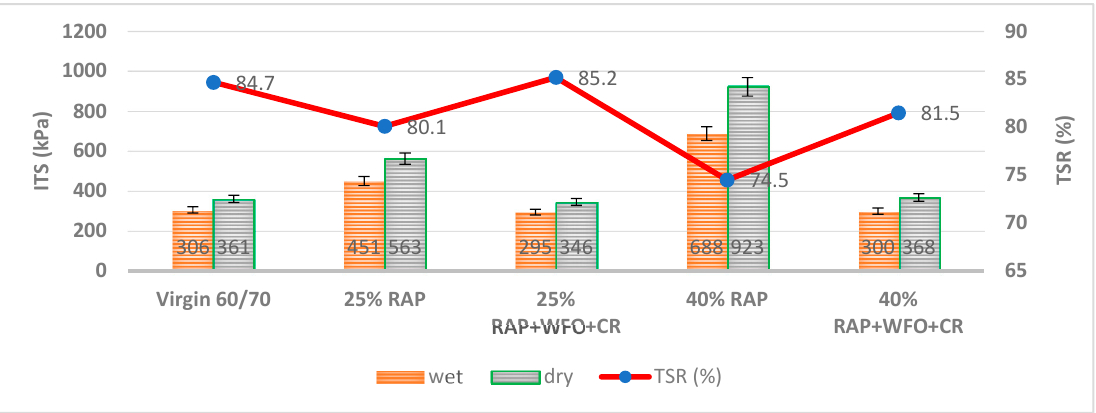
Figure 3. TSR for the virgin, RAP, and recycled asphalt mixtures. The asphalt mixture with 25% RAP had a TSR of 80.1%, which fulfilled the specification limit of 80%. The asphalt mixture with 40% RAP had a TSR of 74.5% and did not meet the criteria limit of the moisture sensitivity test. Adding RAP to the asphalt mixture increased the TSR values, which was consistent with the findings by Peralta et al. [52]. Adding WFO and CR enhanced the moisture resistance and increased the TSR of the recycled asphalt mixture. According to Wen et al. [53], the addition of WFO into the RAP asphalt mixture significantly increased the TSR result, contributing to similar results to the virgin asphalt mixture concerning the dosage of the WFO. The asphalt mixture containing WFO, CR and 25% RAP showed a 5.1% increase in TSR relative to the asphalt mixture with 25% RAP. The asphalt mixture containing WFO, CR and 40% RAP showed a 7% increase in TSR, relative to the asphalt mixture with 40% RAP. The higher TSR could be due to the combined effect of WFO and CR in enhancing the cohesion between the aggregate and asphalt binder and the adhesion between the aged and virgin asphalt binder, which resulted in better moisture resistance of the recycled asphalt mixture. The asphalt mixture with 25% RAP and 40% RAP and the combination of CR and WFO led to an increase in the TSR, which caused similar results to virgin asphalt mixture with 85.2% and 81.5%, respectively.